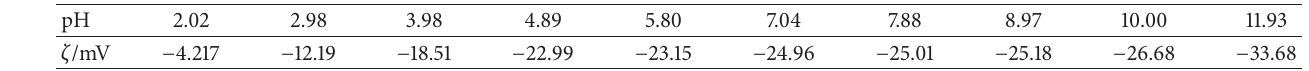
Table 2: The zeta potentials of WS at different pH.